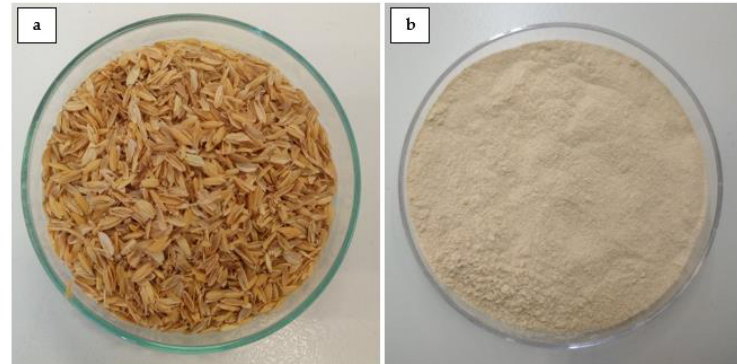
Figure 1. ( a ) As-received flakes of rice husk; ( b ) rice husk flour (RHF).